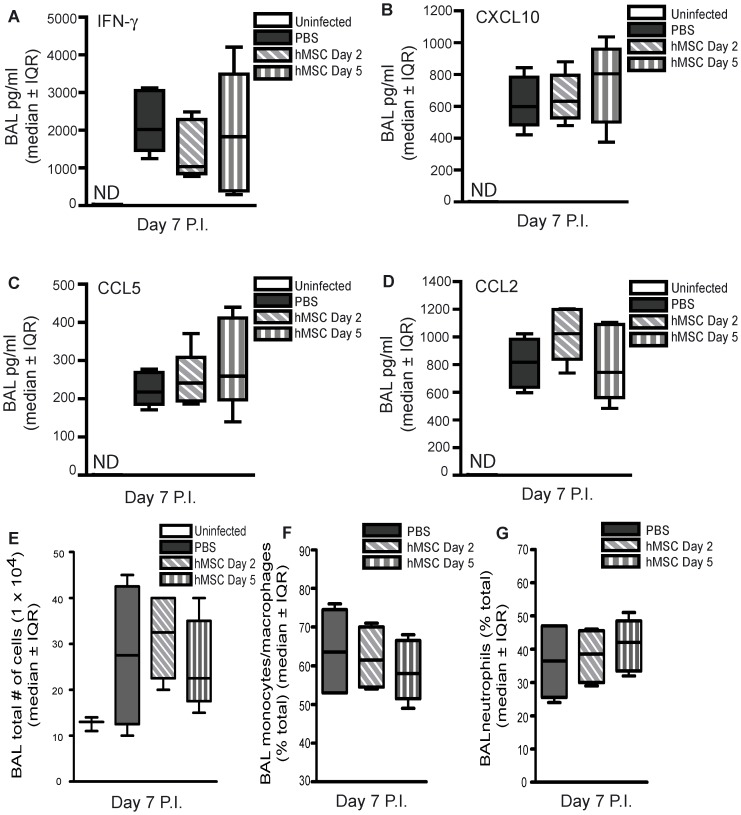
Therapeutic administration of hMSCs failed to decrease pulmonary inflammation or modify BAL inflammatory cell counts in experimental severe influenza.Eight week-old male C57Bl/6 mice infected with 425 EID50 influenza A/PR/8 virus and administered 2.5×105 hMSCs (passage 3) on day 2 or day 5 P.I. were sacrificed on day 7 P.I. BAL was performed. (A–D) No significant difference in BAL fluid cytokine and chemokines (IFN-γ, CXCL10, CCL2 or CCL5) was observed between mice administered hMSCs on day 2 or day 5 P.I. and infected control mice administered PBS (One-way ANOVA, n = 5/group, representative of 2 independent experiments). (E) The total number of BAL inflammatory cells was similar for hMSC-treated mice and infected control mice administered PBS (one-way ANOVA, n = 6/group). There was no significant difference in the total percentage of BAL (F) monocytes/macrophages and (G) neutrophils between mice administered hMCS and infected control mice administered PBS (one-way ANOVA, n = 6/group). Error bars represent interquartile range (IQR). ND = nondetectable.